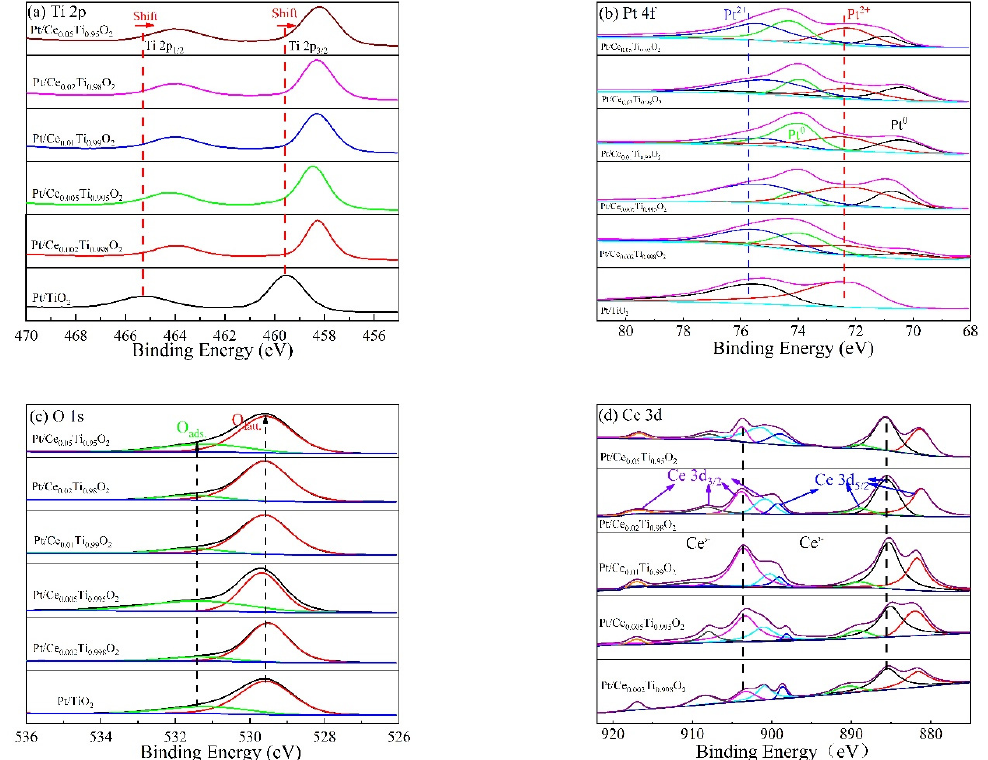
Figure 6. XPS spectra of Pt/Ce x Ti 1 − x O 2 catalysts: ( a ) Ti 2p, ( b ) Pt 4f, ( c ) O 1s, and ( d ) Ce 3d.